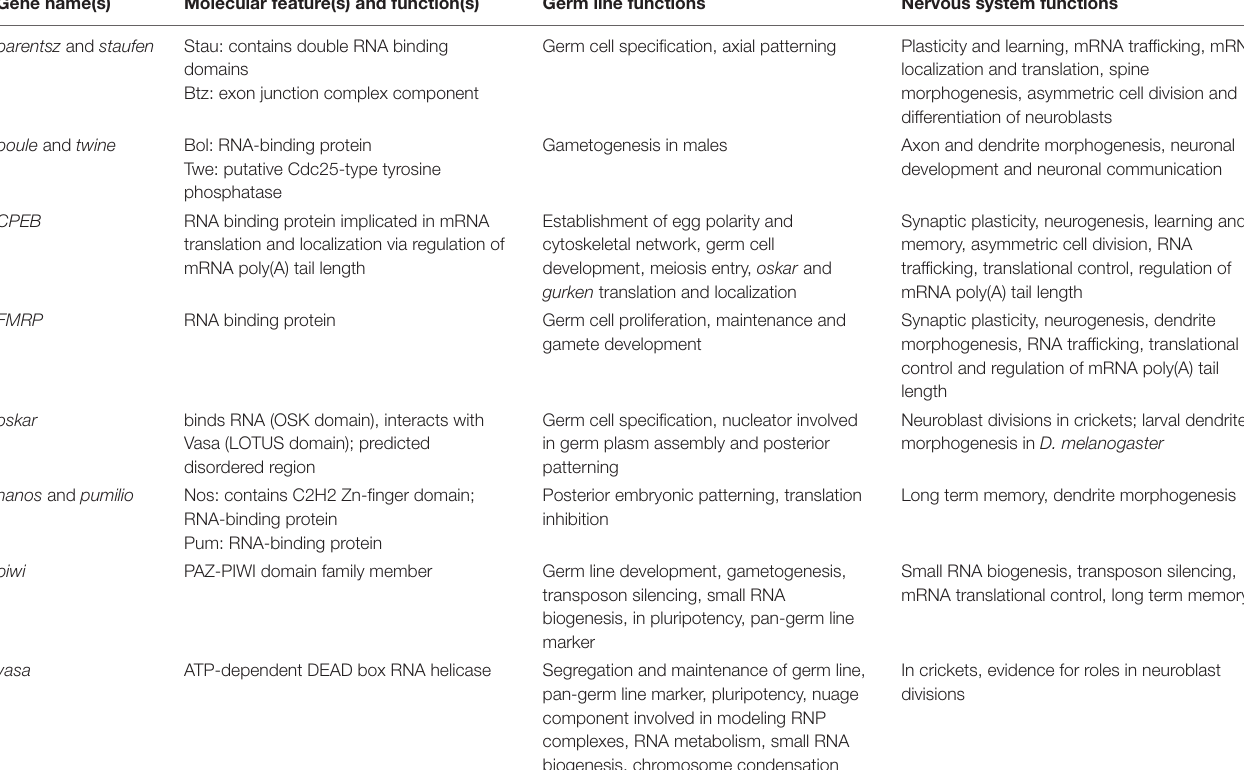
TABLE 1 | Summary of germ line and nervous system roles of genes discussed in the text, listed here in alphabetical